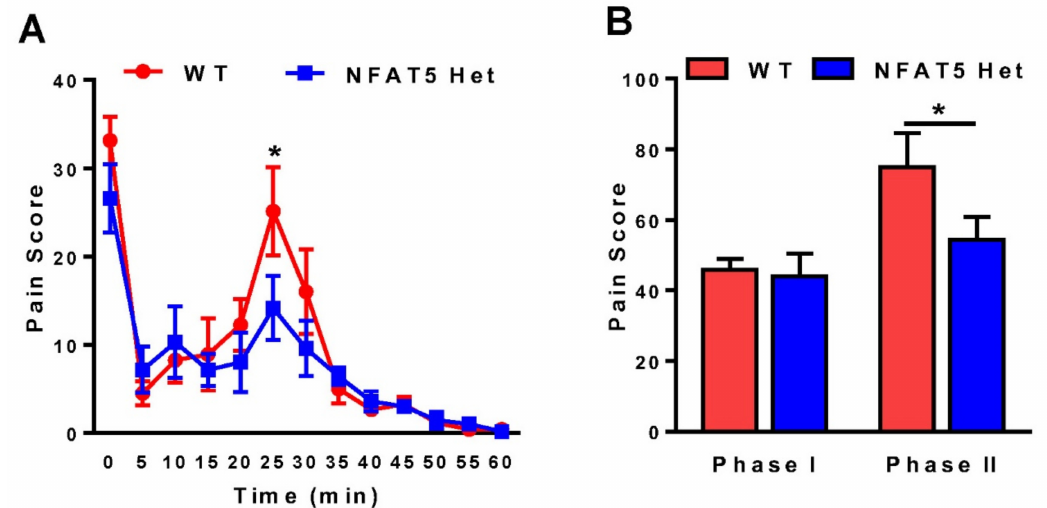
Figure 1. Formalin-induced pain behaviors in wild-type (WT) and NFAT5-Het mice. ( A ) After 10 µ L of 2% formalin was administered under the skin of the plantar surfaces of the right hind paws in WT and NFAT5-Het mice, formalin-induced pain behaviors, including lifting, flinching, and licking, were measured for 60 min at 5 min intervals. Data are expressed as the means ± SEMs (two-way ANOVA with Bonferroni’s post-hoc test, * p < 0.05 vs. WT at 25 min, n = 8). ( B ) Total pain scores were classified as phase I (0–15 min) and phase II (15–60 min) in WT and NFAT5-Het mice. Data are expressed as the means ± SEMs (one-way ANOVA with Tukey’s post-hoc test, * p < 0.05 vs. WT, n = 7–8). ANOVA = analysis of